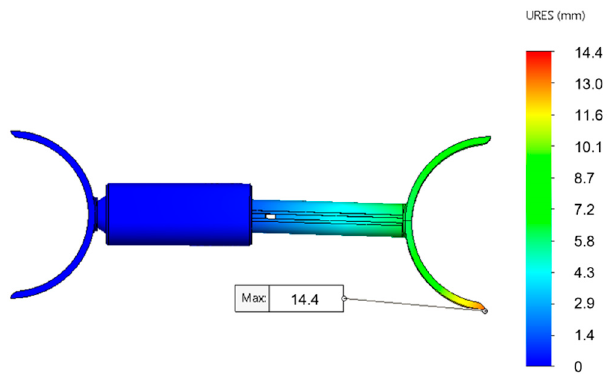
Figure 17. Distribution of resultant displacements for load case 2.